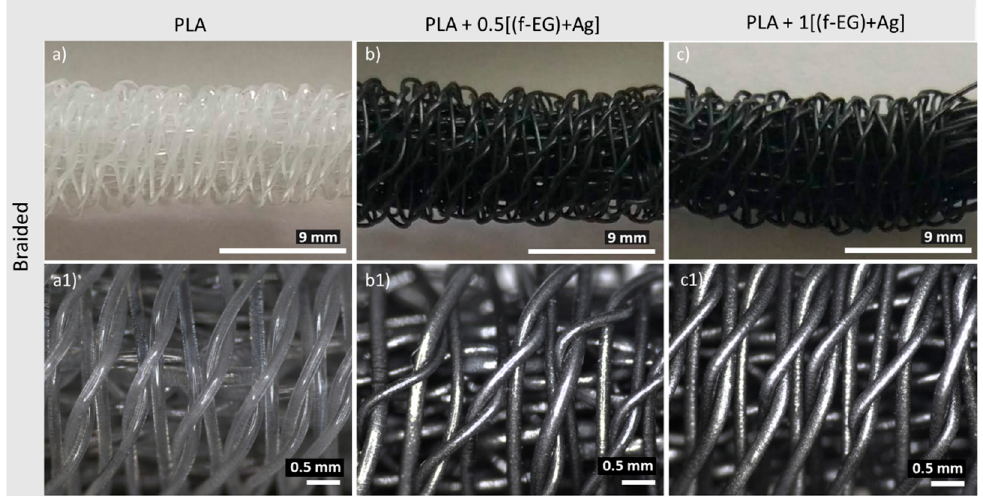
Figure 4. General view of braided scaffolds (longitudinal direction) containing: ( a —PLA; b —PLA+0.5[(f-EG)+Ag]; c —PLA+1[(f-EG)+Ag]) and the corresponding optical images at higher magnification ( a1 – c1 ).